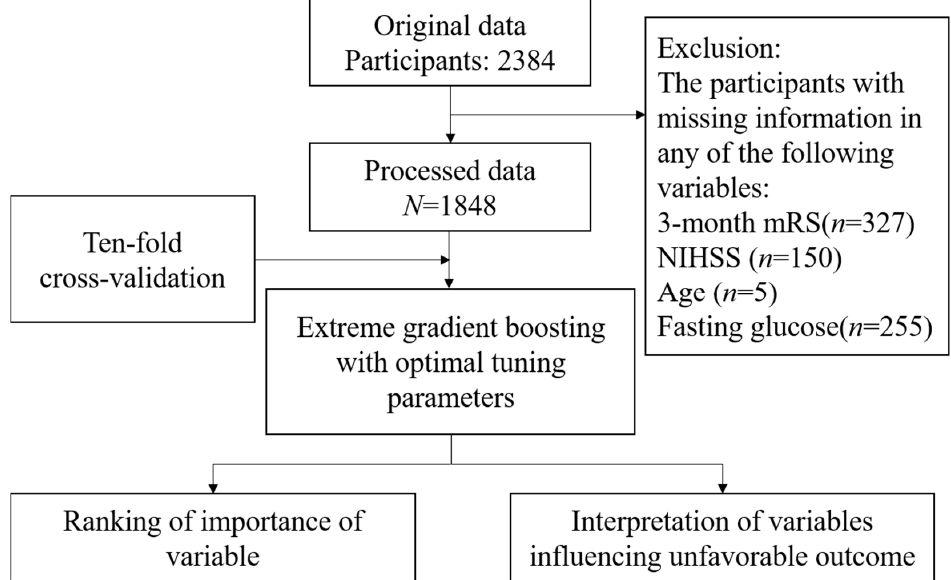
Figure 1. Analytical flowchart of development of the model for predicting outcome three months after stroke.